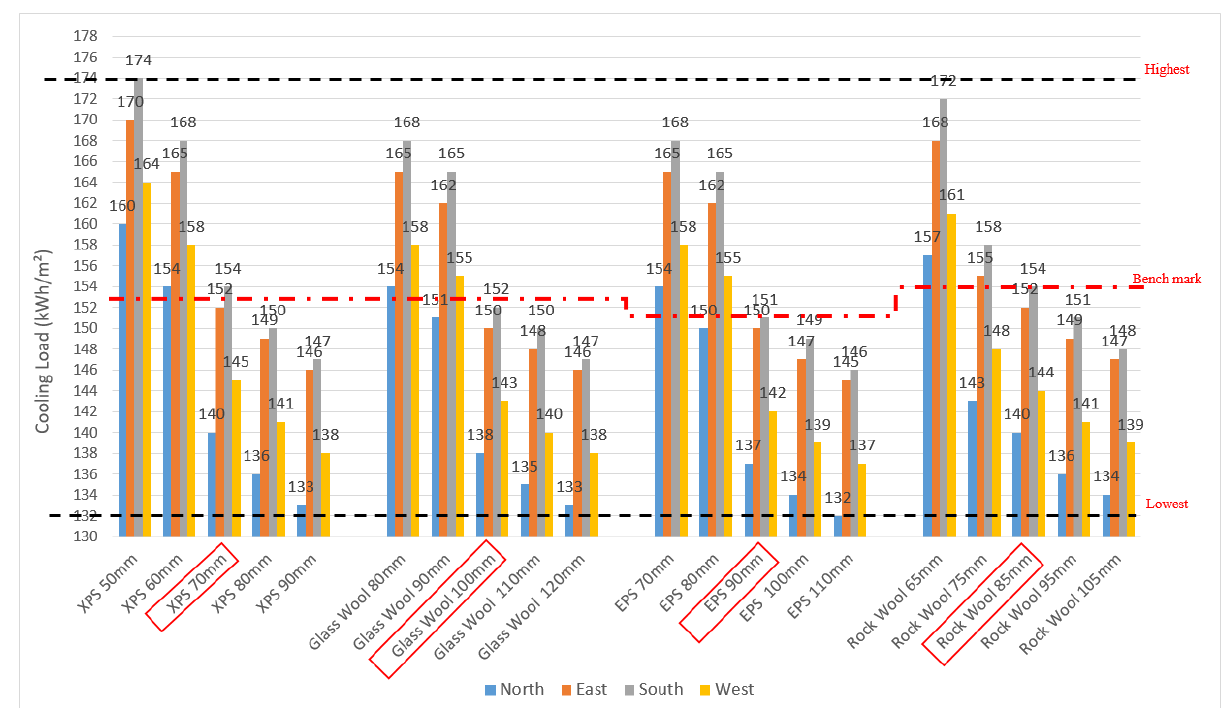
Figure 9. Impact of orientation on cooling loads for different insulation material thicknesses.